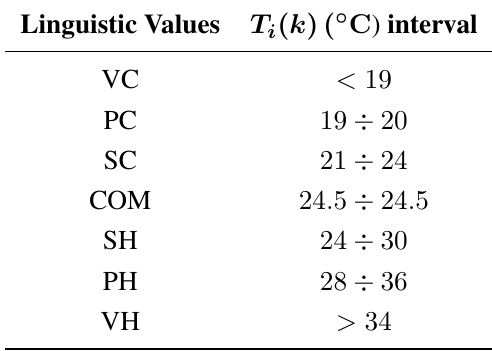
Table 11. Adjusted membership function T